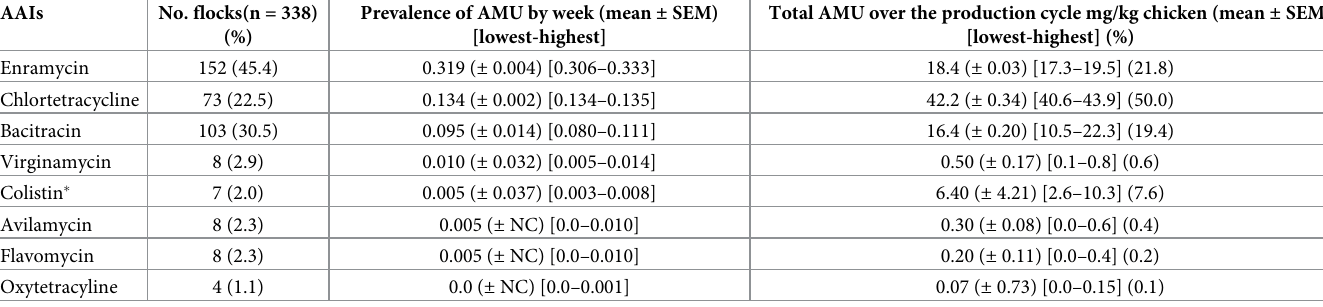
Table 2. AMU in commercial feed among 338 small-scale chicken flocks over 6,041 observation weeks. AAIs No. flocks(n = 338) (%)